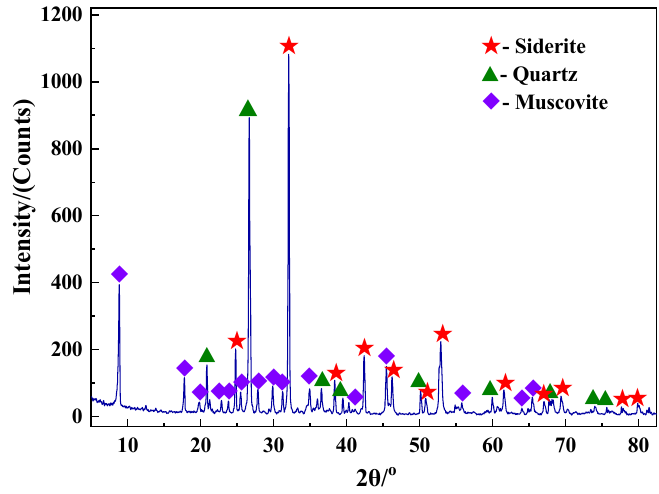
Figure 1. XRD pattern of siderite.